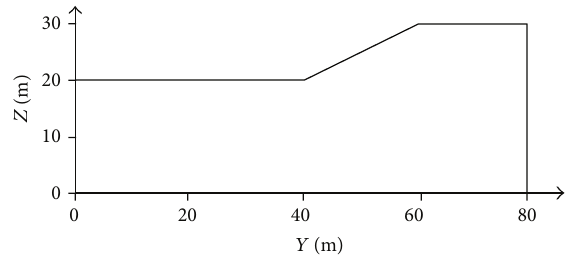
Figure 11: Geometry of 2D section of example problem 1.